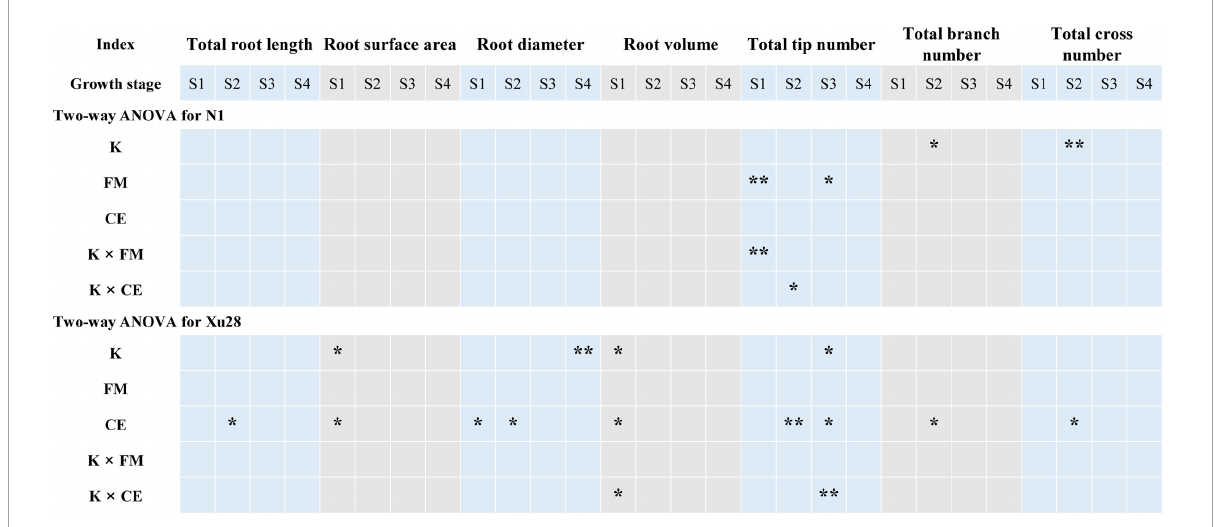
FIGURE3 Two-way ANOVA for the effects potassium (K) and F. mosseae (FM) or C. etunicatum (CE) inoculation on root morphological traits of sweet potato. Asterisks denote significant differences ( t -test; * P < 0.05; ** P <